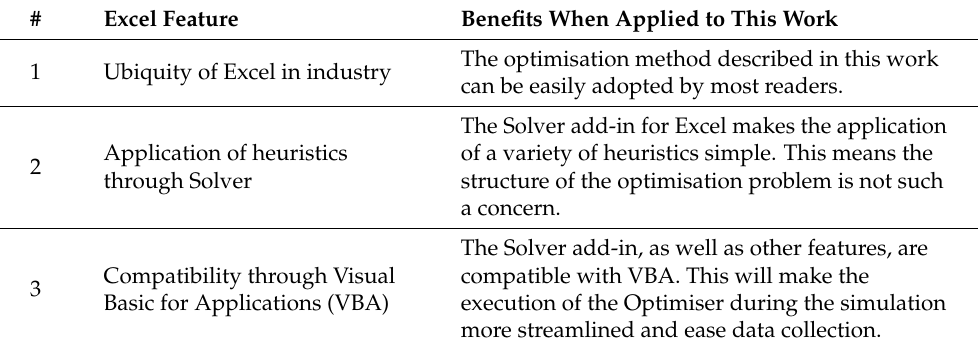
Table 2. The benefits of Microsoft Excel as the software package for creating the